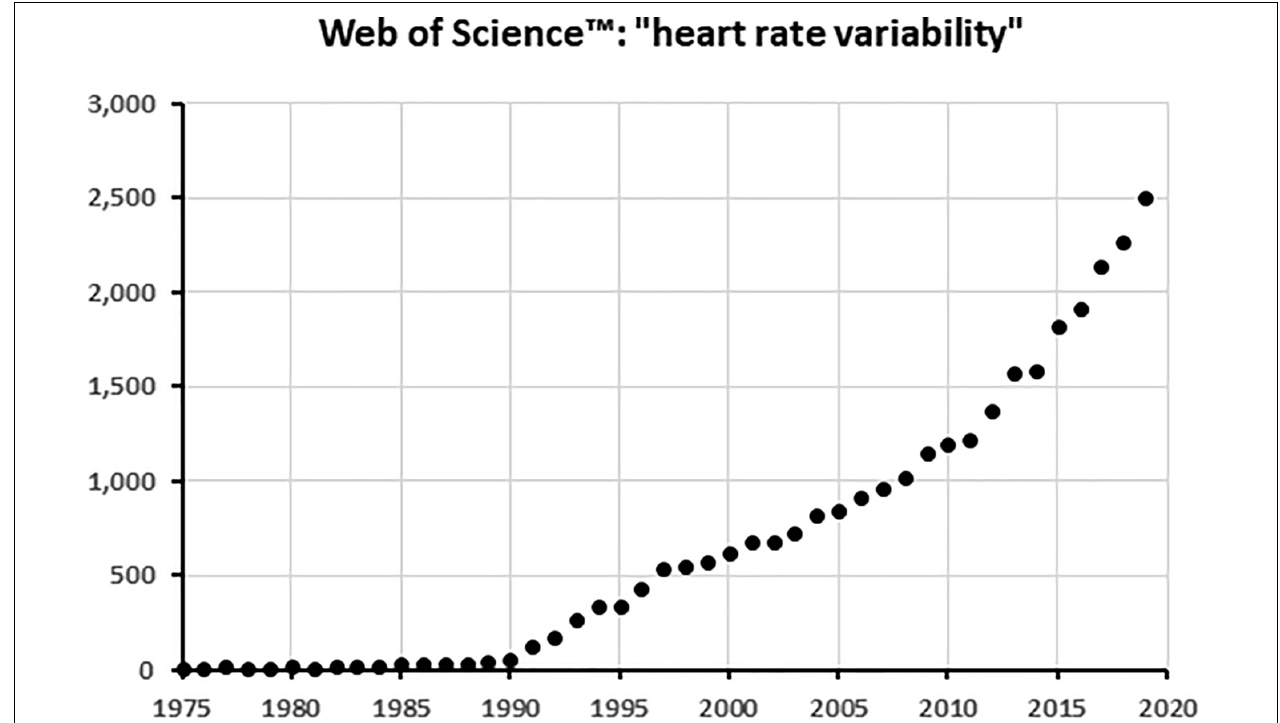
FIGURE 1 | The number of articles with “Heart rate variability” in the title per year, as found in the Web of Science core collection TM of scientific journals. When plotted on a logarithmic scale, the curve becomes an almost perfect straight line from 1996 onward, demonstrating its exponential